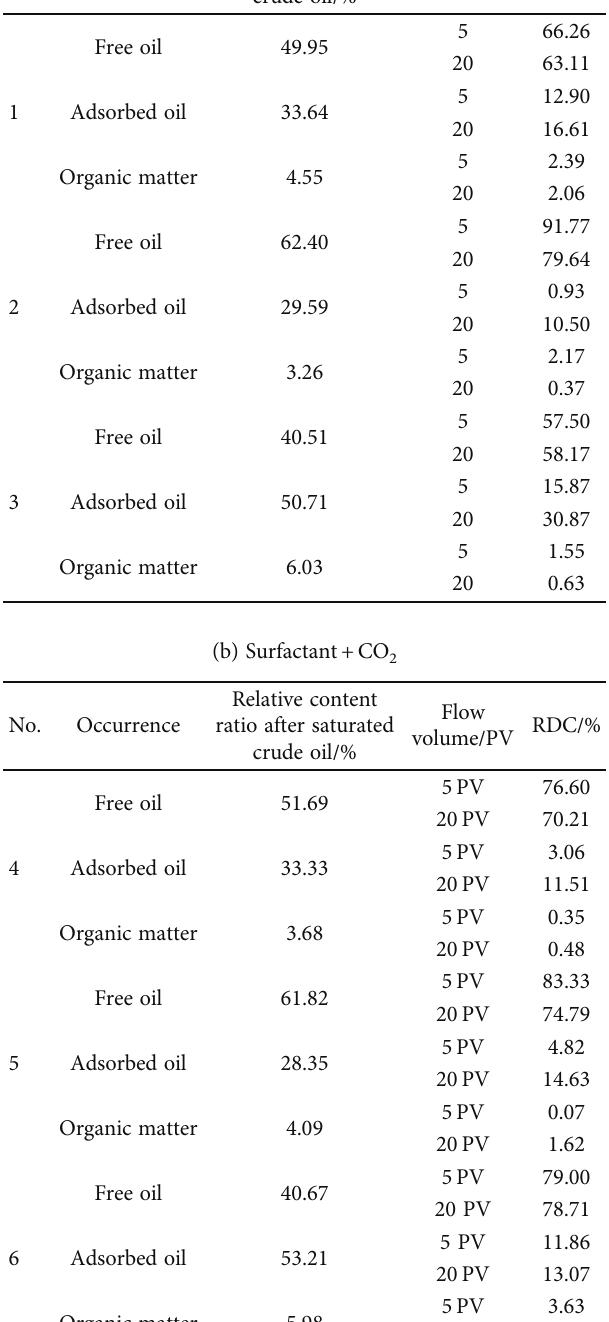
-T spectral signals in 1 2